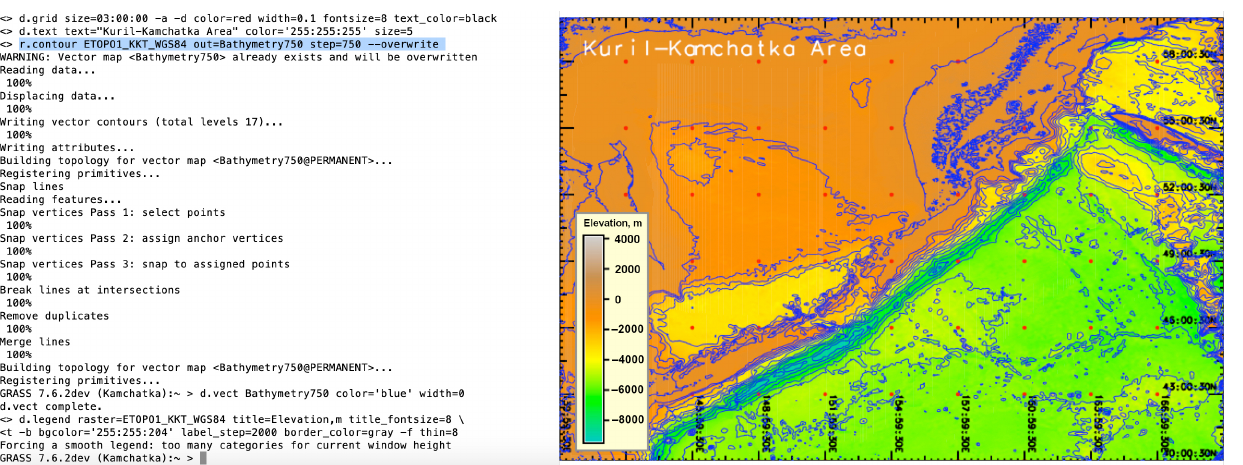
Figure 4. Plotting isolines by the ‘r.contour’ module and visualising the raster in the ‘elevation’ colour table. Source: